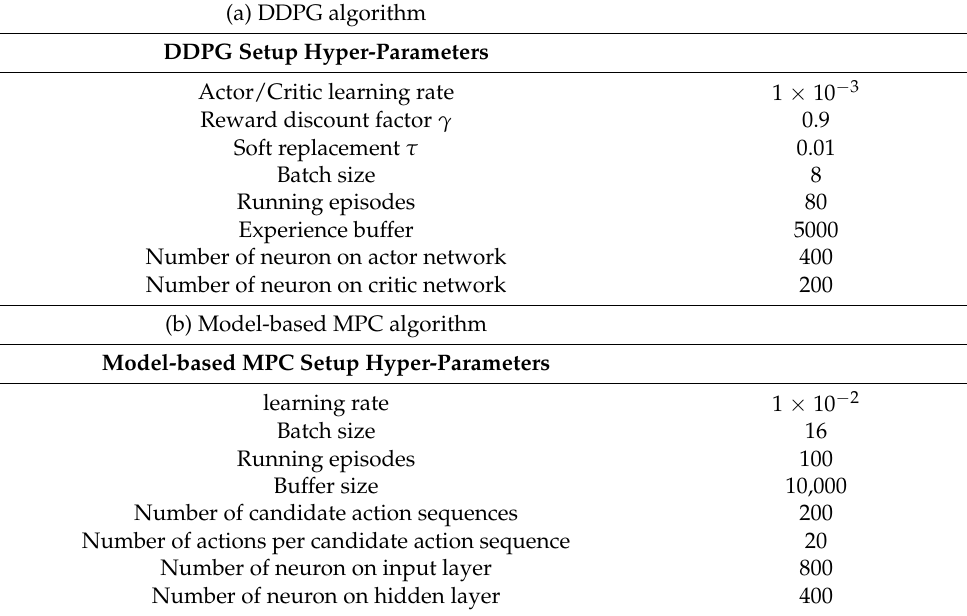
Figure 14. Comparison of training times. Table 1. Hyperparameters of the two algorithms.